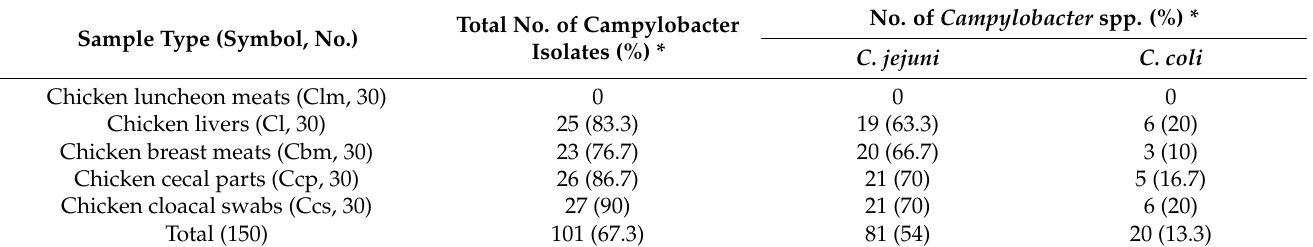
Table 4. Prevalence of Campylobacter species in various chicken samples in Sharkia Governorate,